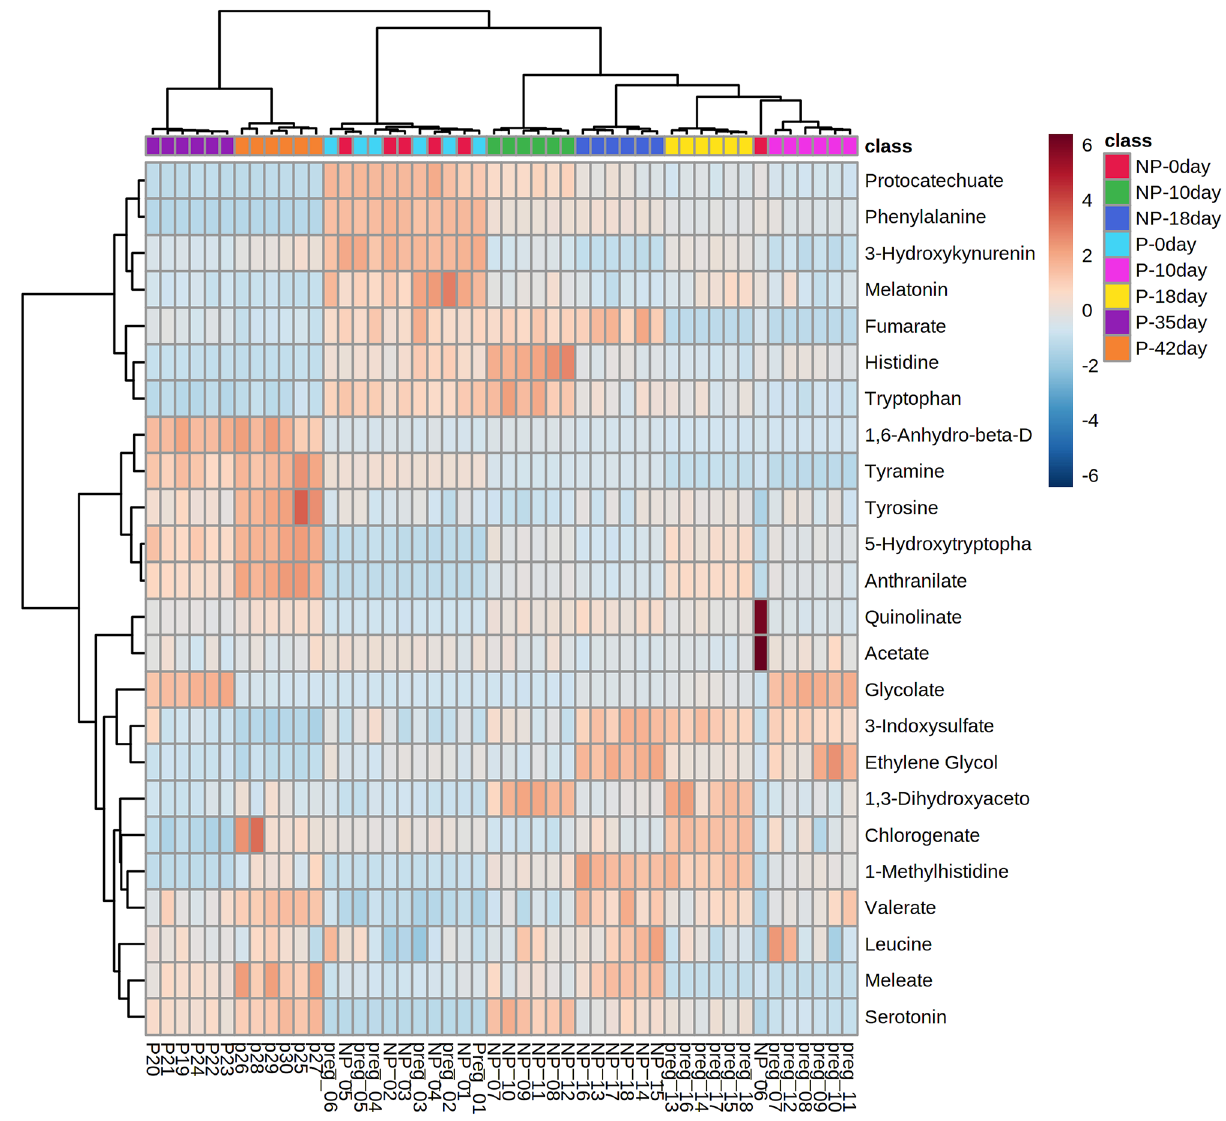
Figure 3. Hierarchical clustering of the differentially expressed metabolites depicted in the heat map. Only metabolites from the day 0 samples of pregnant (P) and non-pregnant (NP) group mingled with each other while the metabolites of the other group-specific samples at different days orient them in different distant clads in the correlation with Anthranilate ( r = − 0.60769; P < 0.001) and 5-Hydroxytryptophan ( r = − 0.62684; P < 0.001) (Fig. 6). Analysis of predictive ability of the potential biomarkers. The predictive ability of the individual potential biomarkers as identified through ANOVA was analysed by calculating their Receiver Operating Char- acteristic (ROC) area under the curve (AUC) value through classical univariate ROC curve analysis. The ROC AUC values were 0.824 for Tyrosine with Sensitivity: 0.733 (0.583–0.867) and Specificity: 0.833 (0.638–1) at 95% confidence interval (CI); 0.82 for Anthranilate with Sensitivity: 0.667 (0.5–0.8) and Specificity: 0.889 (0.722–1) at 95% CI; 0.787 for 5-Hydroxytryptophan with Sensitivity: 0.667 (0.432–0.867) and Specificity: 0.889 (0.722–1) at 95% CI and 0.613 for 3-Hydroxykynurenine with Sensitivity: 0.6 (0.449–0.767) and Specificity: 0.722 (0.556– 0.889) at 95% CI (Fig. 7 and Table 2). The possibility of improvement in the prediction efficiency was also verified by employing a combination of more than one manually selected discriminatory metabolite via logistic regres- sion analysis. However, a combination of the four features, viz. Anthranilate, 3-Hydroxykynurenine, Tyrosine, and 5-Hydroxytryptophan (the frequency % in LASSO modeling were 100, 80, 40, and 20 respectively) did not improve the predictive ability yielding ROC-AUC value of 0.785, 95% CI: 0.61–0.912 (Fig. 8a). The average pre- dictive accuracy of the metabolite combination was found to be 0.691 based on 100 cross validations (Fig. 8b). The best ROC-AUC value of 0.804, 95% CI: 0.685–0.922 was achieved by combining Anthranilate, 3-Hydrox-